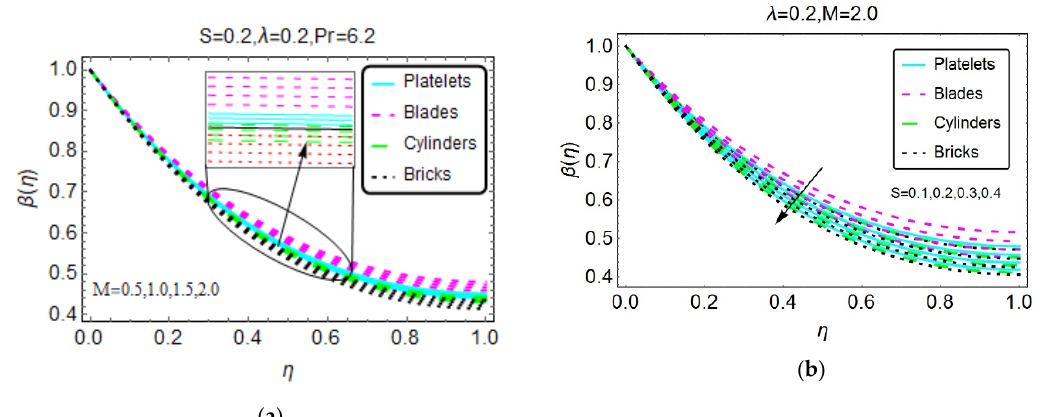
Figure 5. The temperature pattern for different values of ( a ) M and ( b ) S.